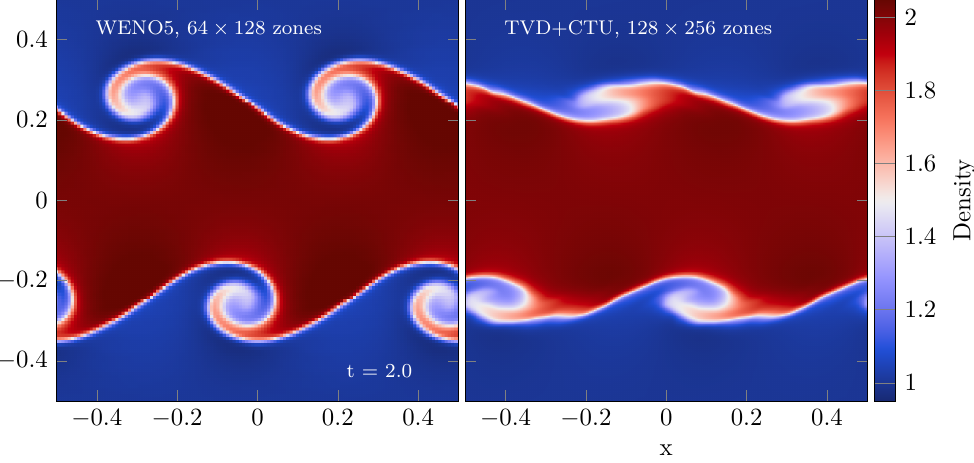
Figure 4. Density in the 2D Kelvin Helmholtz test at time t = 2. Left : WENO5 solution with 64 128 zones; Right : TVD solution with 128 ×